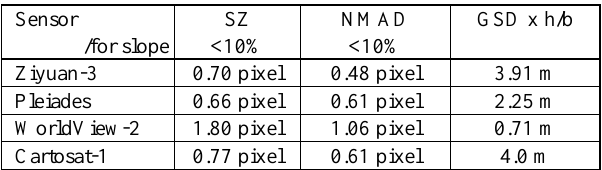
Table 11. Normalized accuracy for slope < 10% and non-forest area: SZ respectively NMAD / (GSD  h